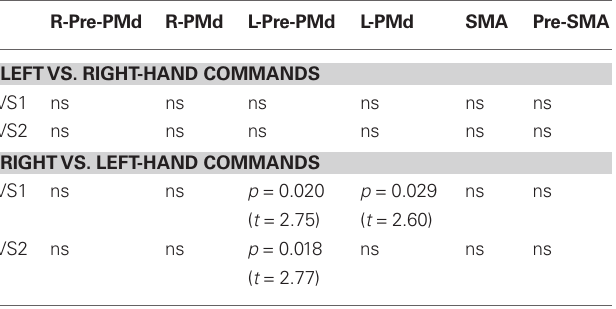
p Values are corrected for multiple comparisons. ns, Not significant; Pre-PMd, dorsal pre-premotor cortex; PMd, dorsal premotor cortex; SMA, supplementary motor area; pre-SMA, pre-supplementary motor